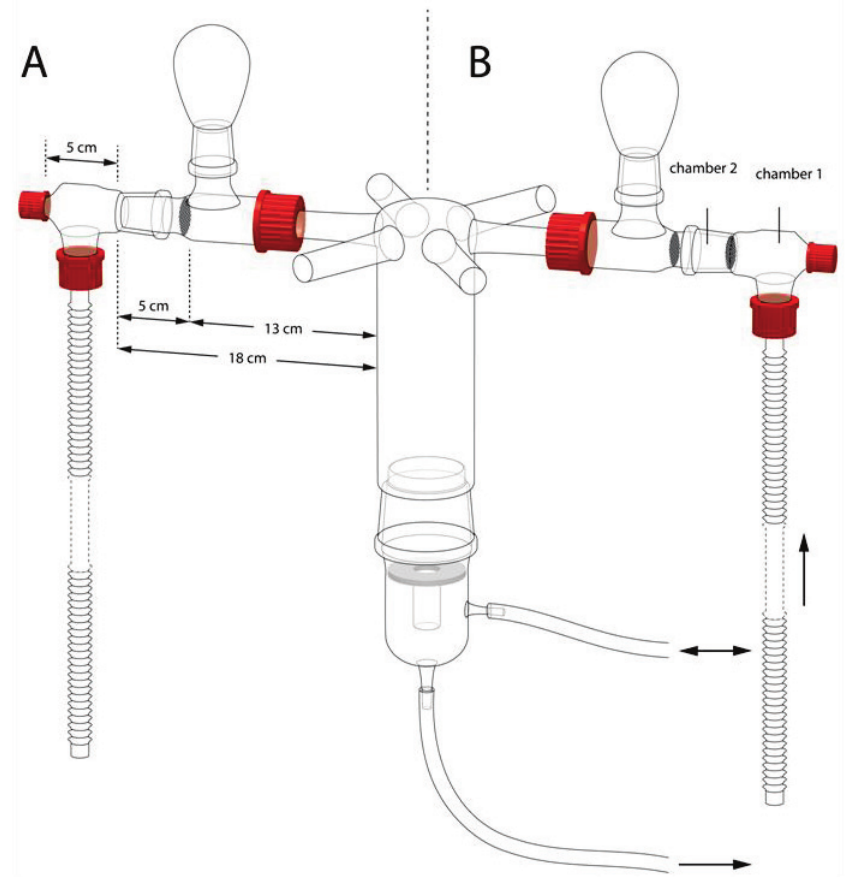
Figure 1. The six-arm olfactometer as it was used to test for attractiveness ( A ) and repellency ( B ). For the repellency tests, Chamber 1 contained virgin females (the source of attraction) and Chamber 2 either no wasps (control) or mated females or males (the source of potential